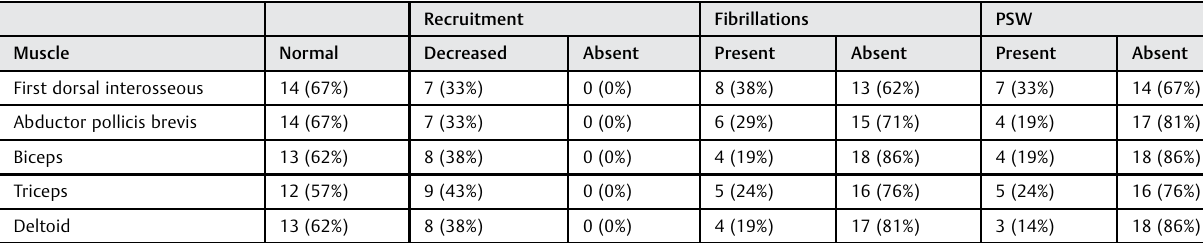
Table 4 Summary of preoperative EMG studies